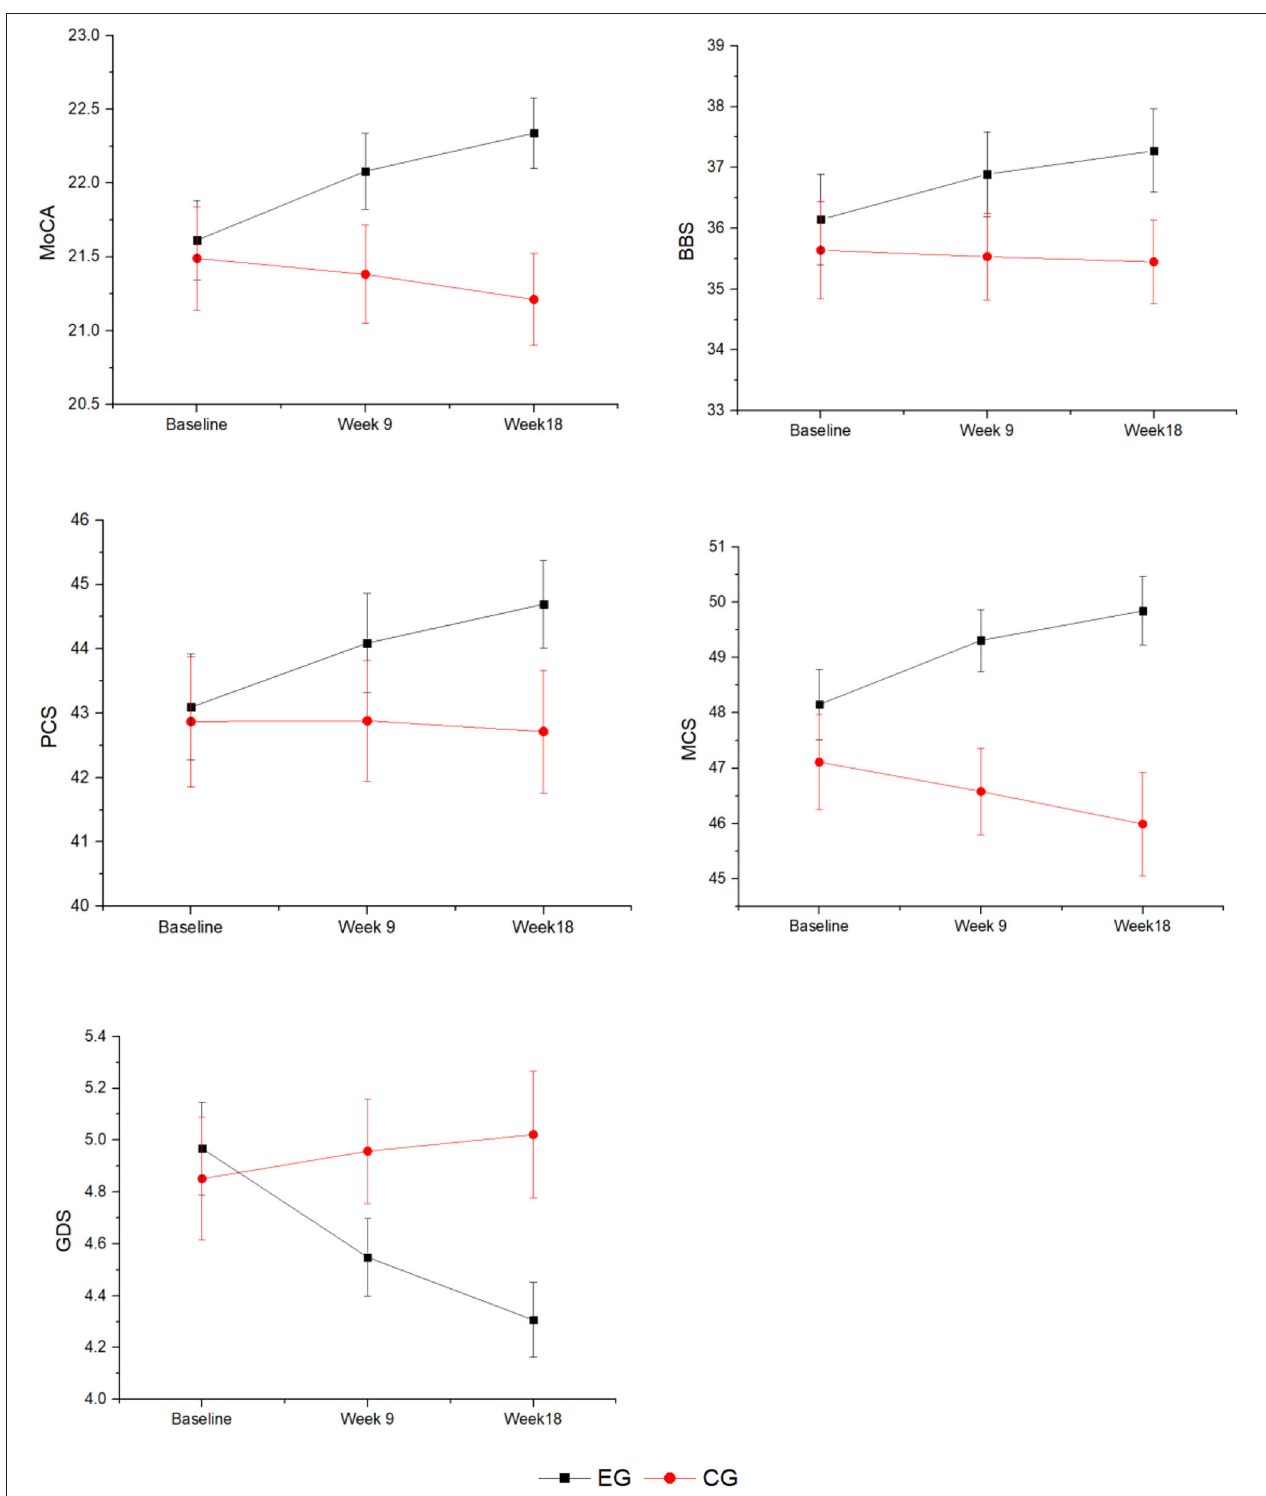
FIGURE 2 | The change trend of the experimental and control groups across time. EG, experimental group; CG, control group; MoCA, Montreal Cognitive Assessment; BBS, Berg Balance Scale; PCS, Physical Component Summary; MCS, Mental Component Summary; GDS, Geriatric Depression Scale.